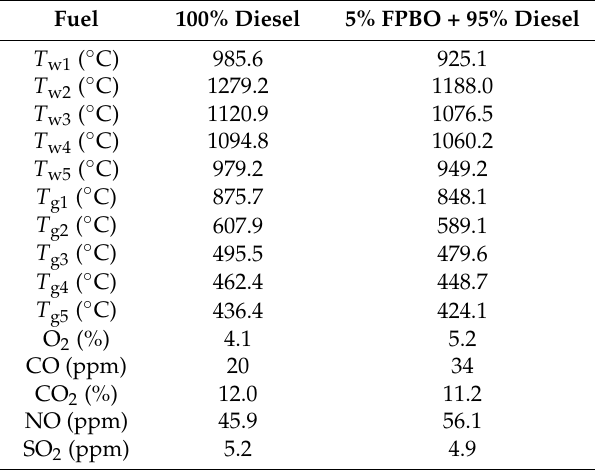
Table 4. Variations in average temperature distribution and gas emissions for diesel alone and the blend of 5% FPBO + 95% diesel under stable combustion